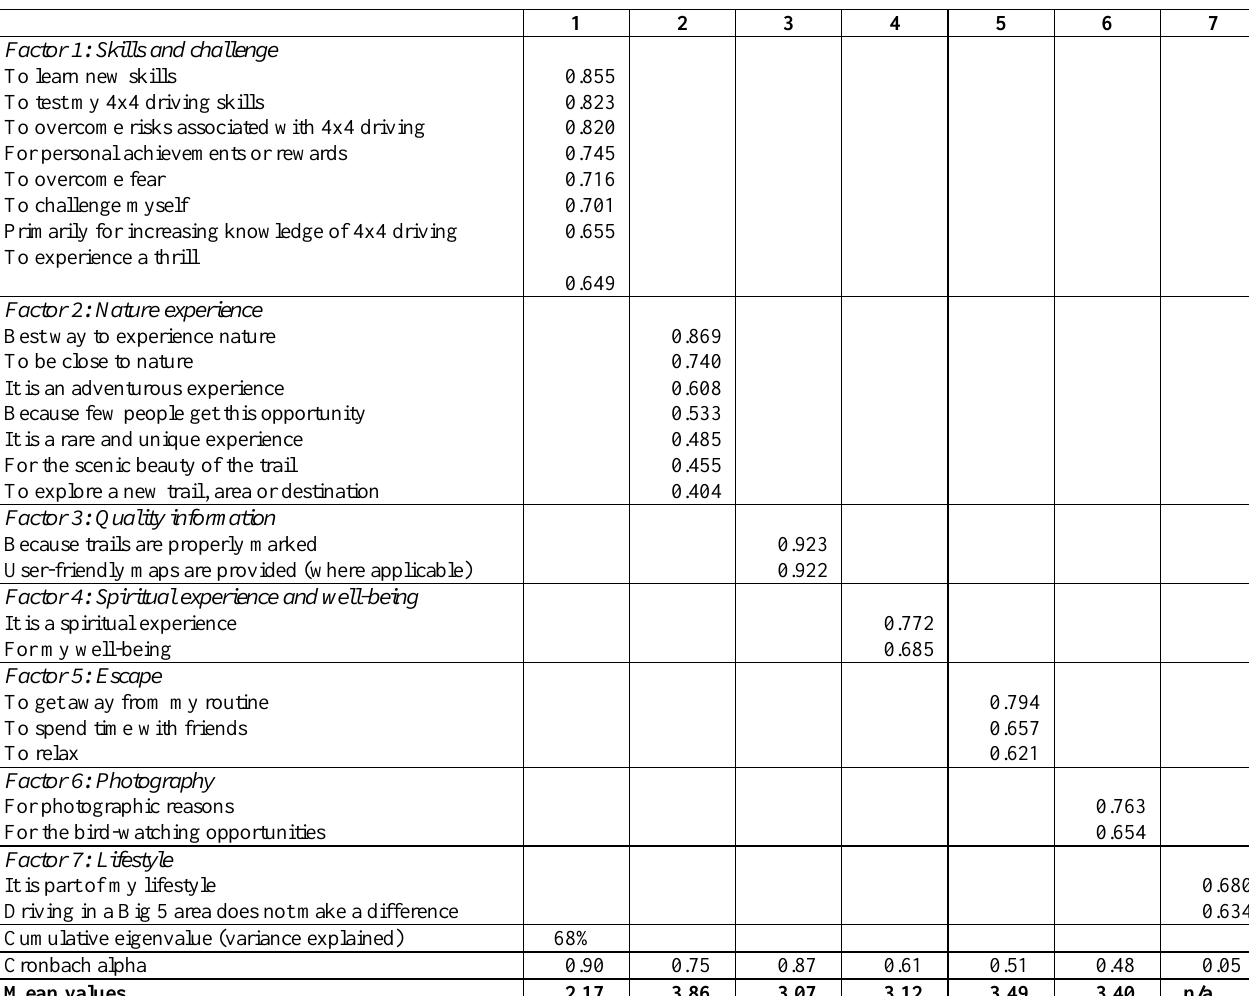
Table 3: Results of factor analysis of motives for using 4x4